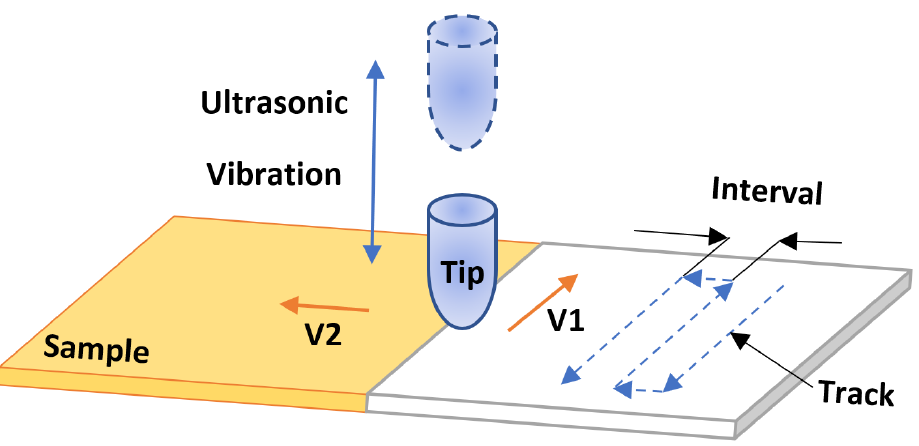
Figure 20. Schematic of the UNSM process.